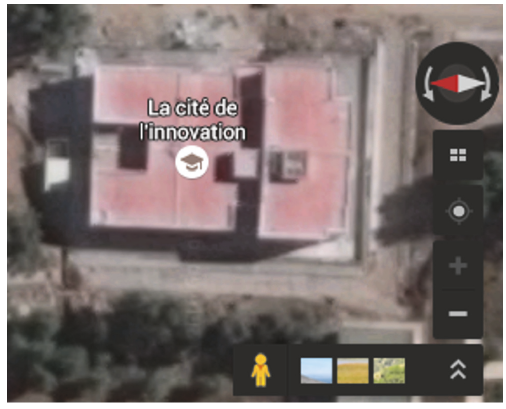
Figure 1: A view of the building taken by Google Maps.